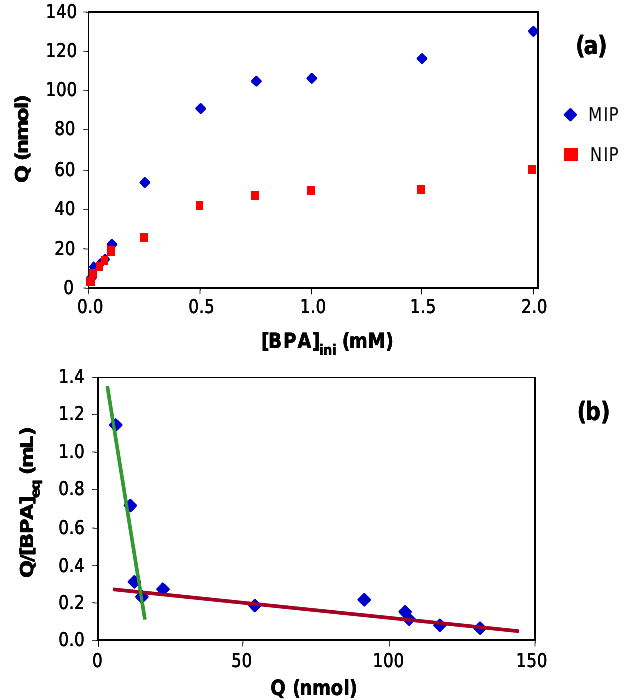
is the concentration of eq